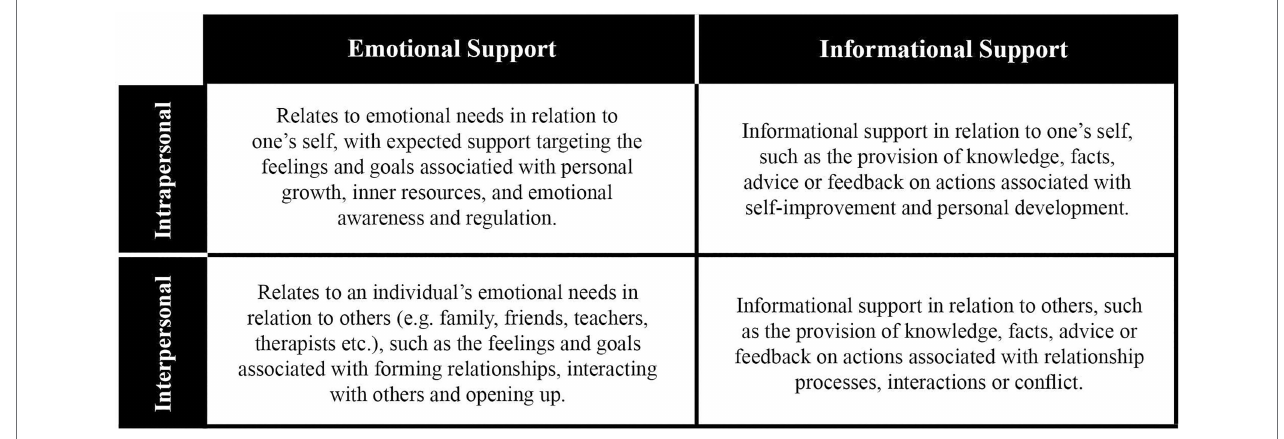
FIGURE 1 | Kooth high-level outcome matrix – Domains for